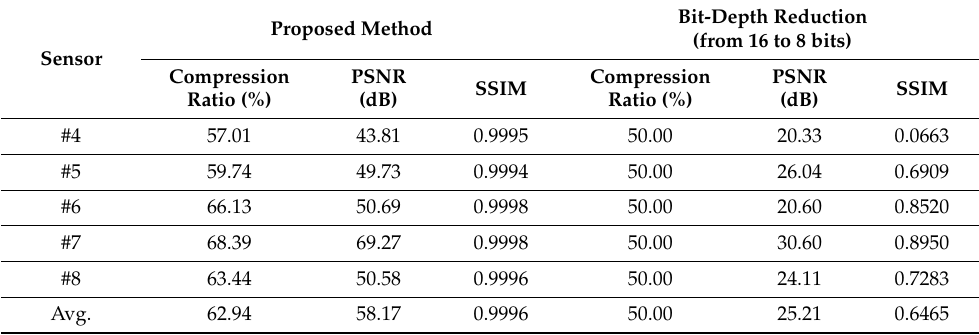
Table 6. Comparison of the compression ratio, peak signal-to-noise ratios (PSNR), and struc- tural similarity (SSIM) index between the original and processed acoustic sensor signals for the proposed